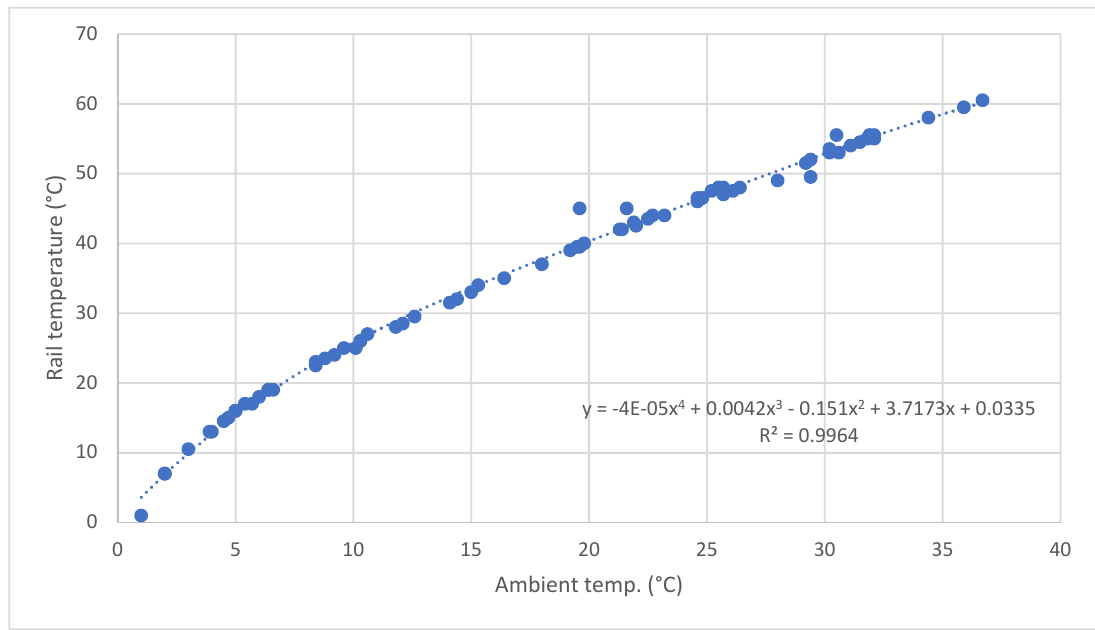
Figure 17. Dependence of the temperature of unloaded rail on ambient temperature (source: own work).